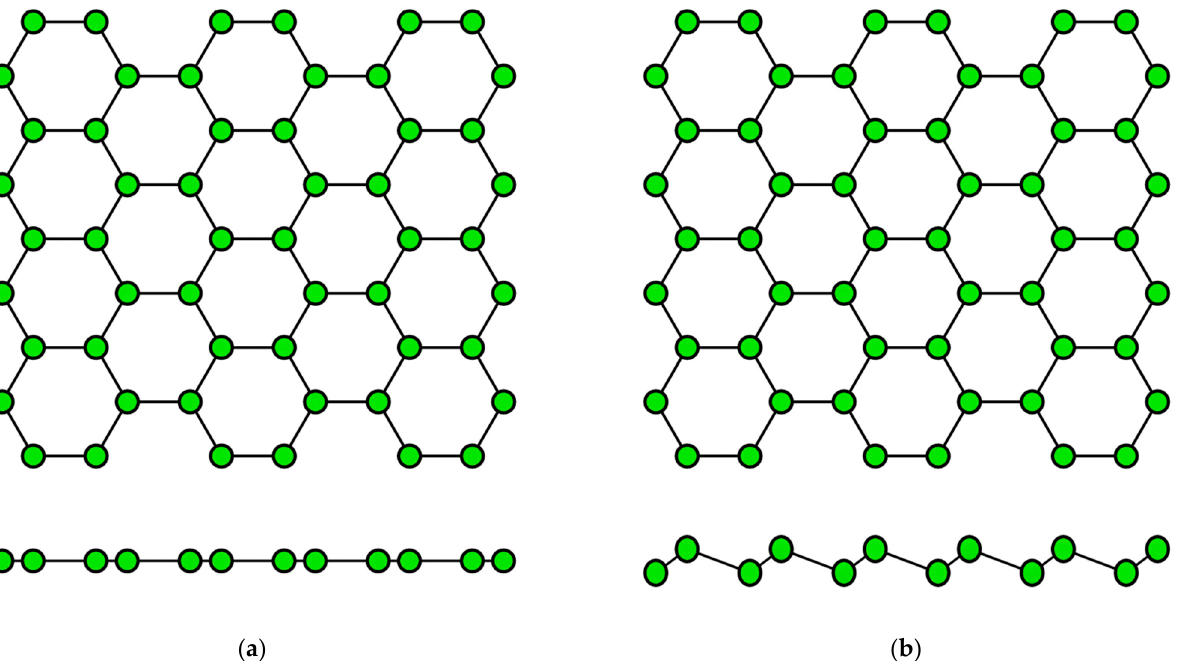
Figure 2. Honeycomb lattice of graphene ( a ) and graphene-like structure of two-dimensional materials of group IVA ( b ) (on this and following figures colored balls represent atoms and black lines represent interatomic bonds).